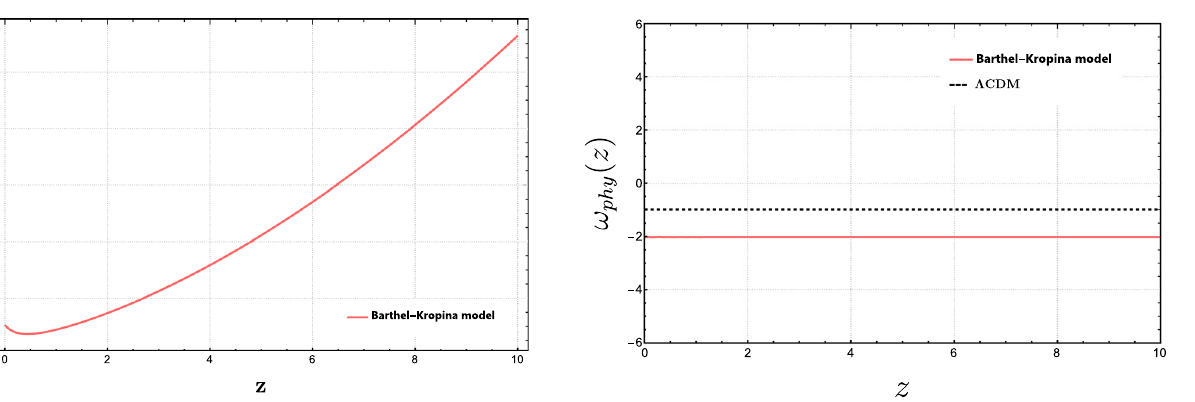
Fig. 12 The evolution of the physical energy density ρ DEphy in the Barthel–Kropina dark energy model, as a function of the redshift z